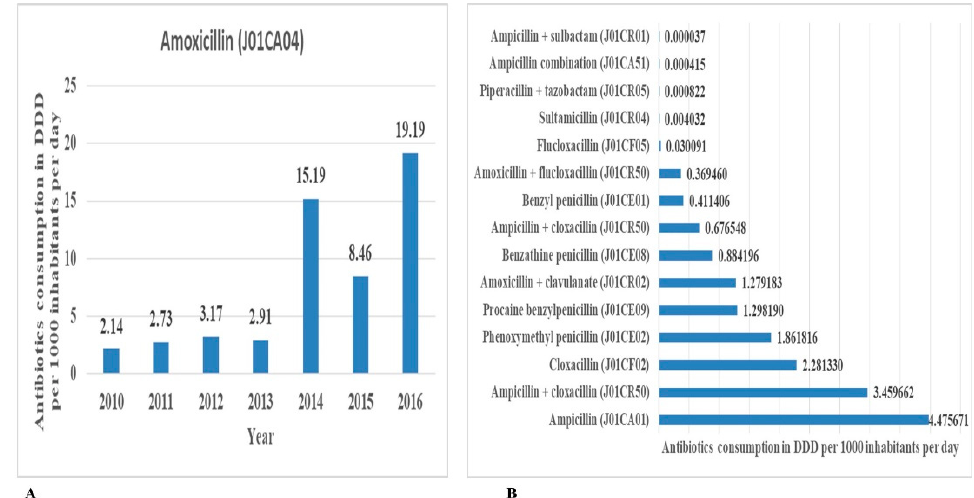
Figure 3. Contribution of each antibiotic in ATC class level J01C ( A ) for amoxycillin per year and ( B ) for the other antibiotics in class J01C utilized over seven years from 2010 to 2016 in Tanzania.